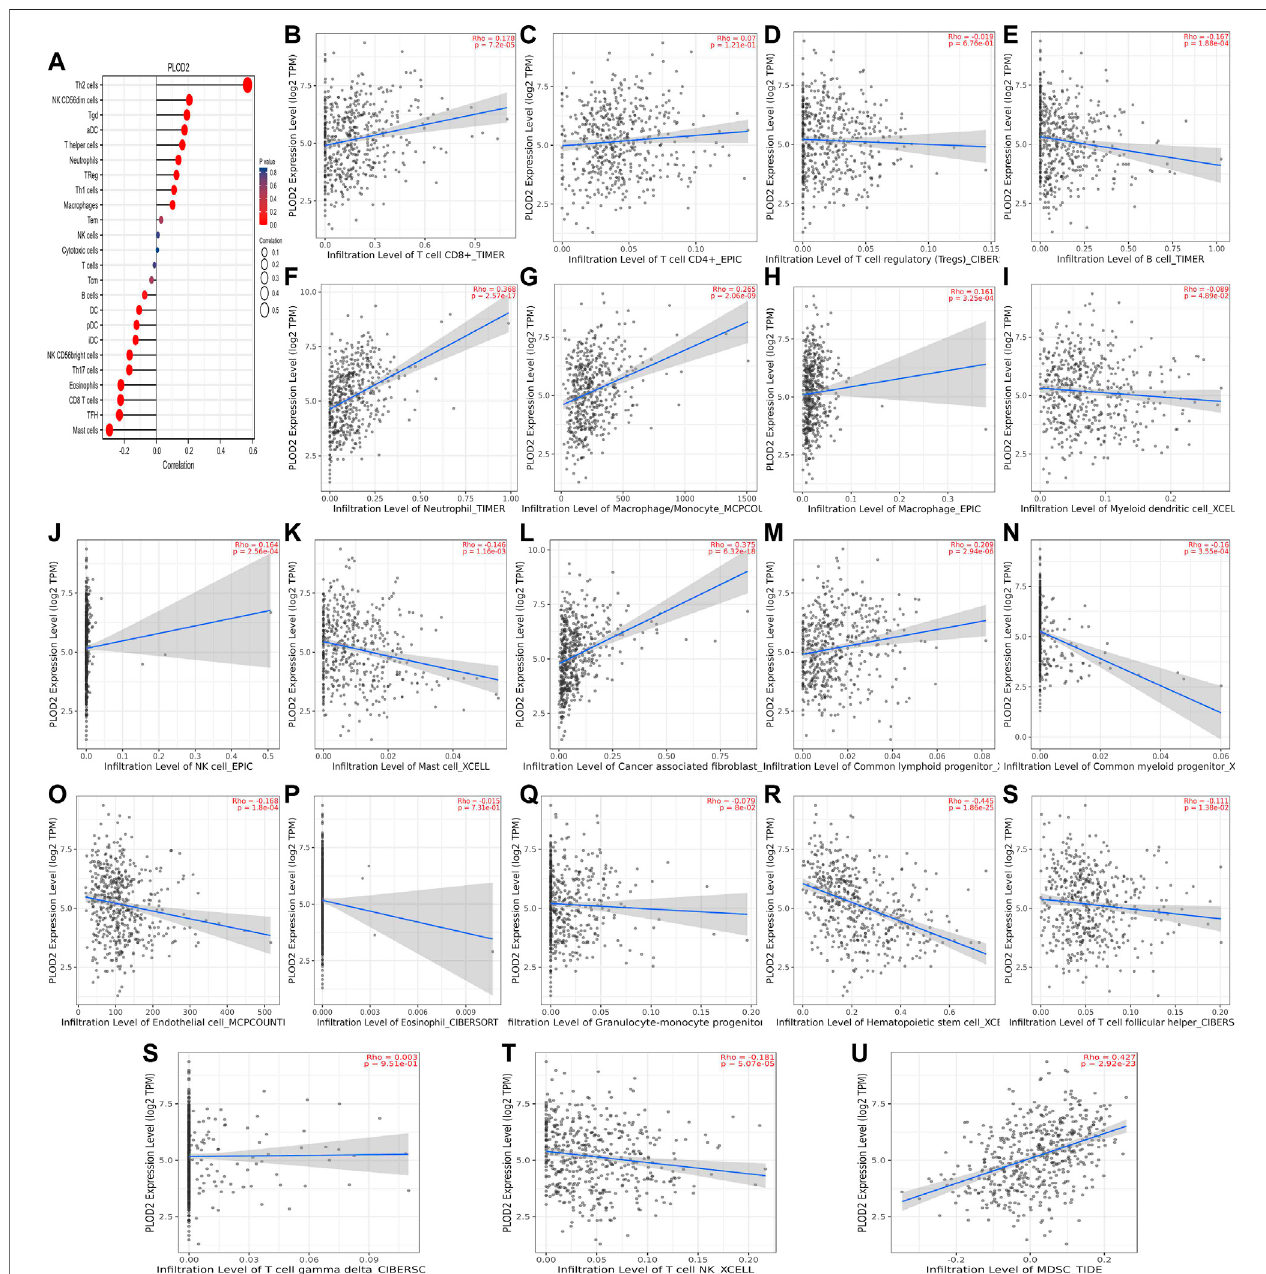
FIGURE10| Associationbetween PLOD2 andimmunein fi ltration. (A) Summaryplotoftherelationshipbetween PLOD2 expressionand immunein fi ltration. (B – U) PLOD2 expression is negatively related to tumor purity and has correlations with TFH, CD8 + T, dendritic, CD56 + NK, mast, and B cells; on the contrary, it is positively correlated with Tregs, macrophages, and cancer-associated fi